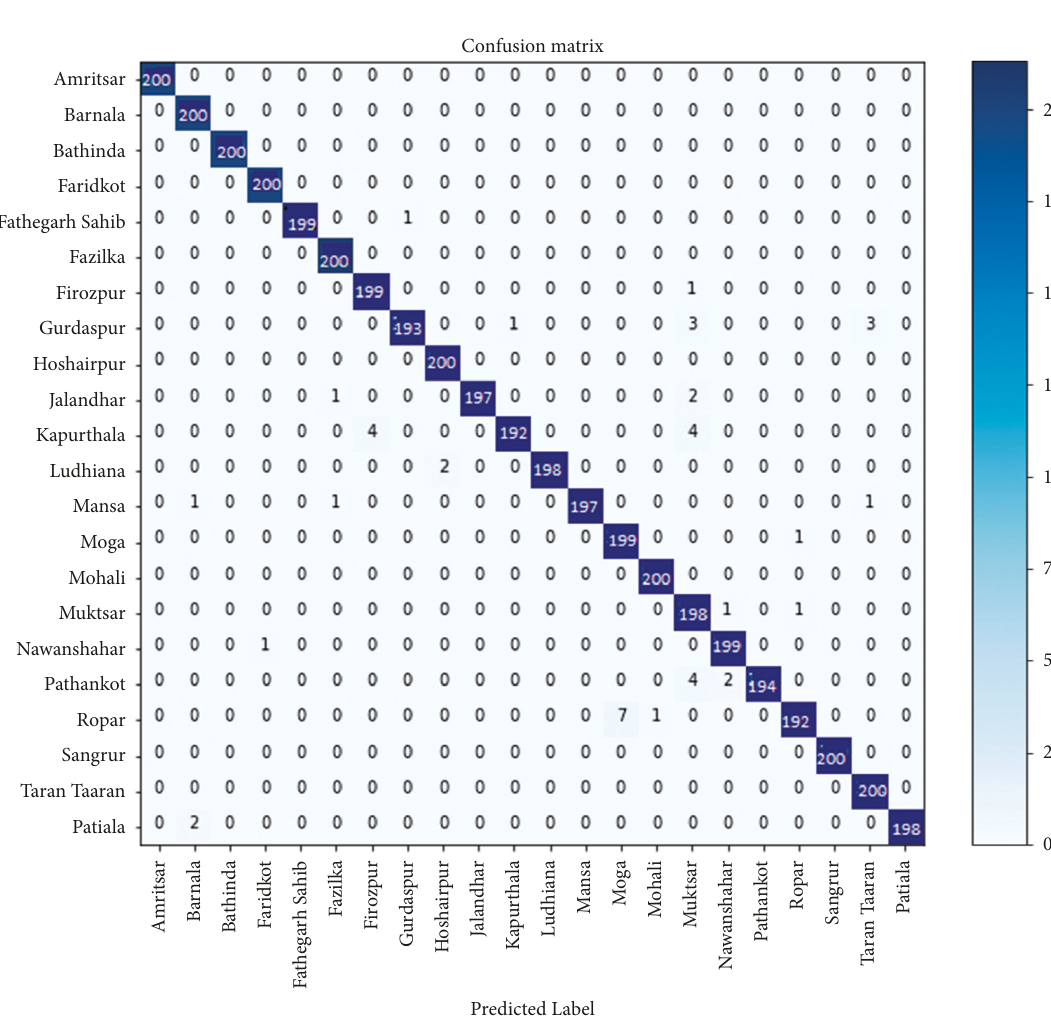
Figure 9: Confusion matrix.